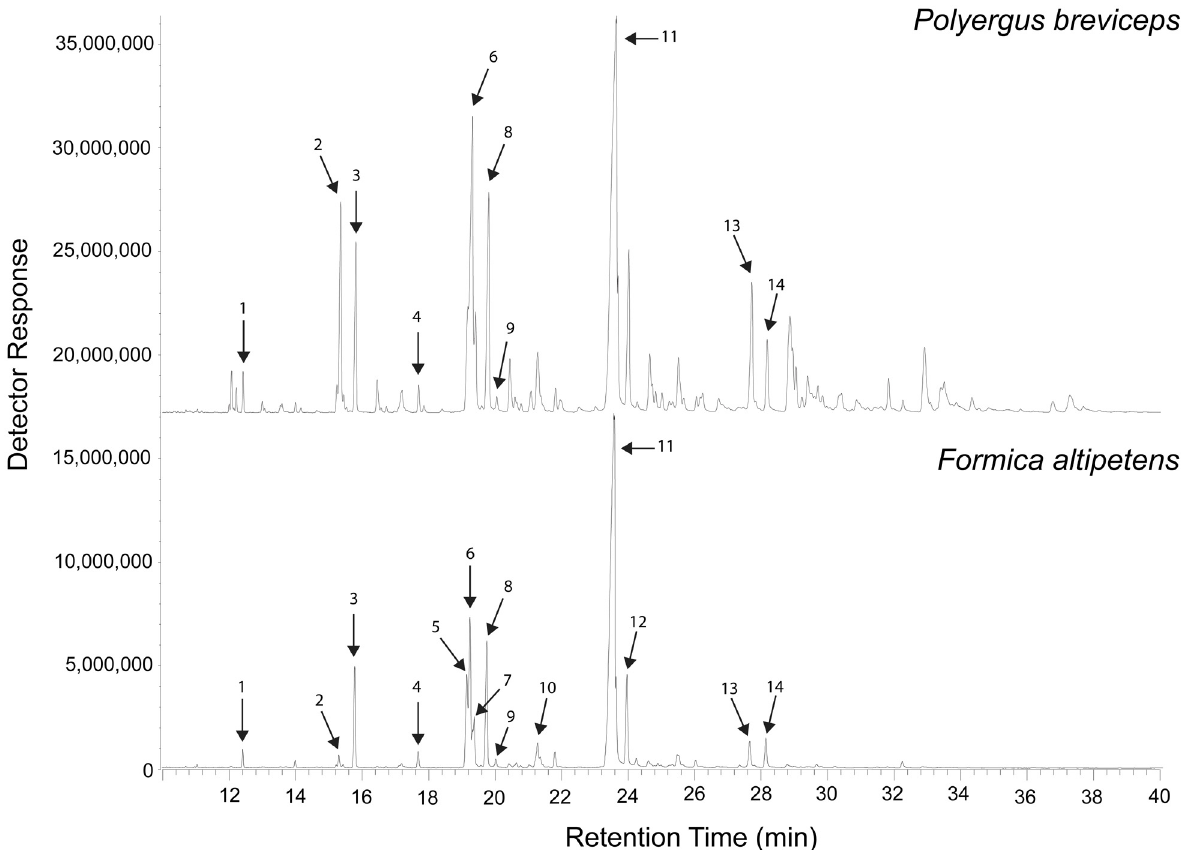
Fig 1. Chemical profiles pooled from 20 Polyergus breviceps workers (top) and 20 Formica altipetens workers (bottom) from 10 different colonies. Numbered peaks correspond to the chemical components in Table